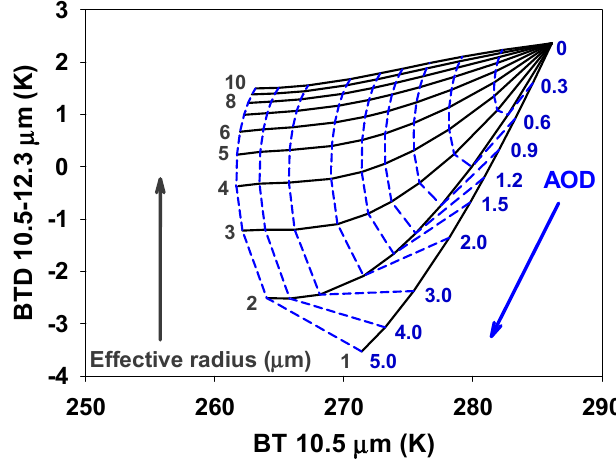
Figure 4. Example of a lookup table for the determination of the volcanic ash optical depth and effective radius (when altitude 2 km, solar zenith angle 30 ° , satellite angle 30 ° , and relative azimuth angle 80 ° ).